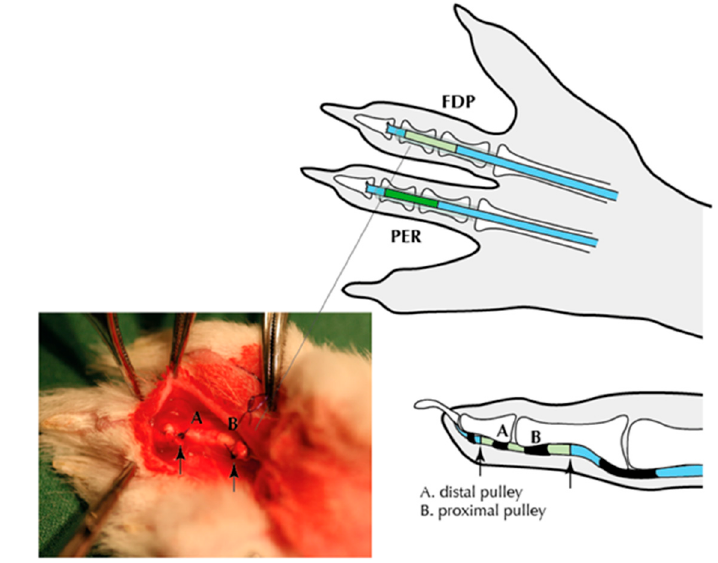
Figure 1. Schematic illustration of the rabbit transplant model. Flexor digitorium profundus (FDP) tendons were transferred from the neighboring digit, and Peroneus tendon (PER) tendons were transferred from a separate incision on the foreleg.